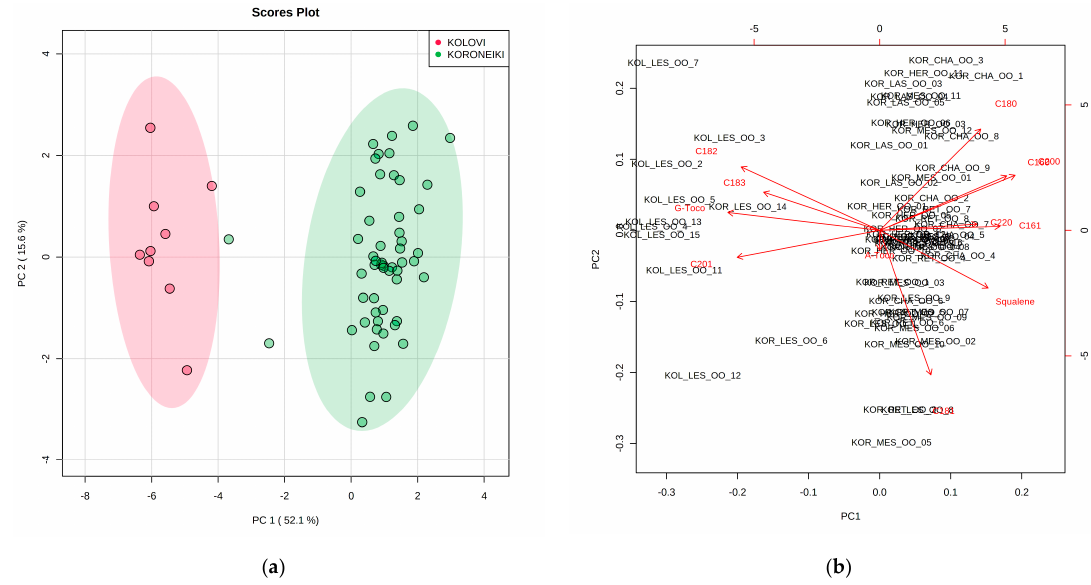
Figure 3. ( a ) Principal Component Analysis (PCA) score plot derived from the concentration of fatty acids, squalene, and α -, γ -tocopherol of EVOOs. The legend indicates the two cultivars tested (Koroneiki, Kolovi) and the colored areas represent the 95% confidence region; ( b ): PCA biplot showing which variables influence the principal components.